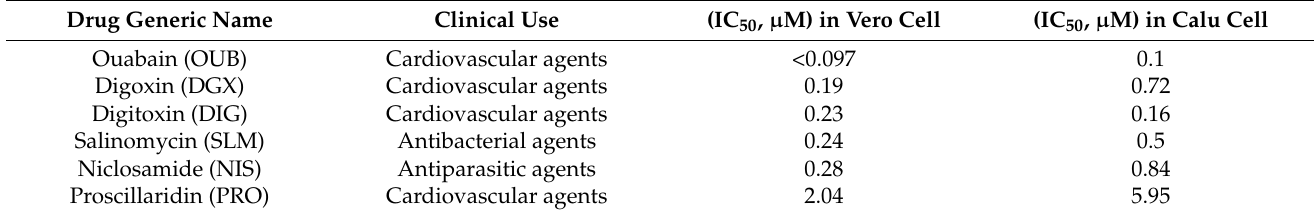
Table 1. FDA-approved drugs are considered tested ligands that were selected for molecular docking. Drug generic names, clinical use, and reported activity against